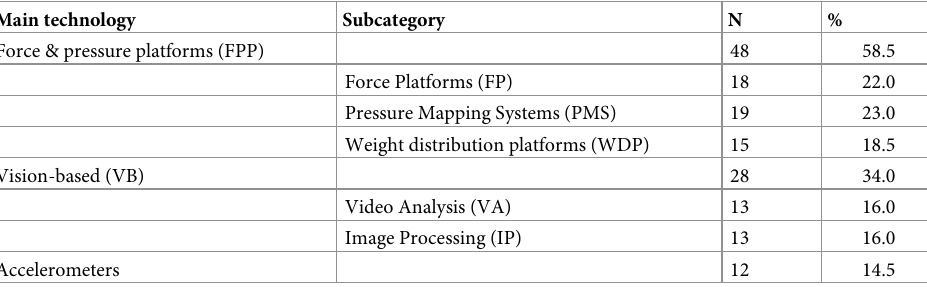
Table 3. Three main gait analysis technologies and their